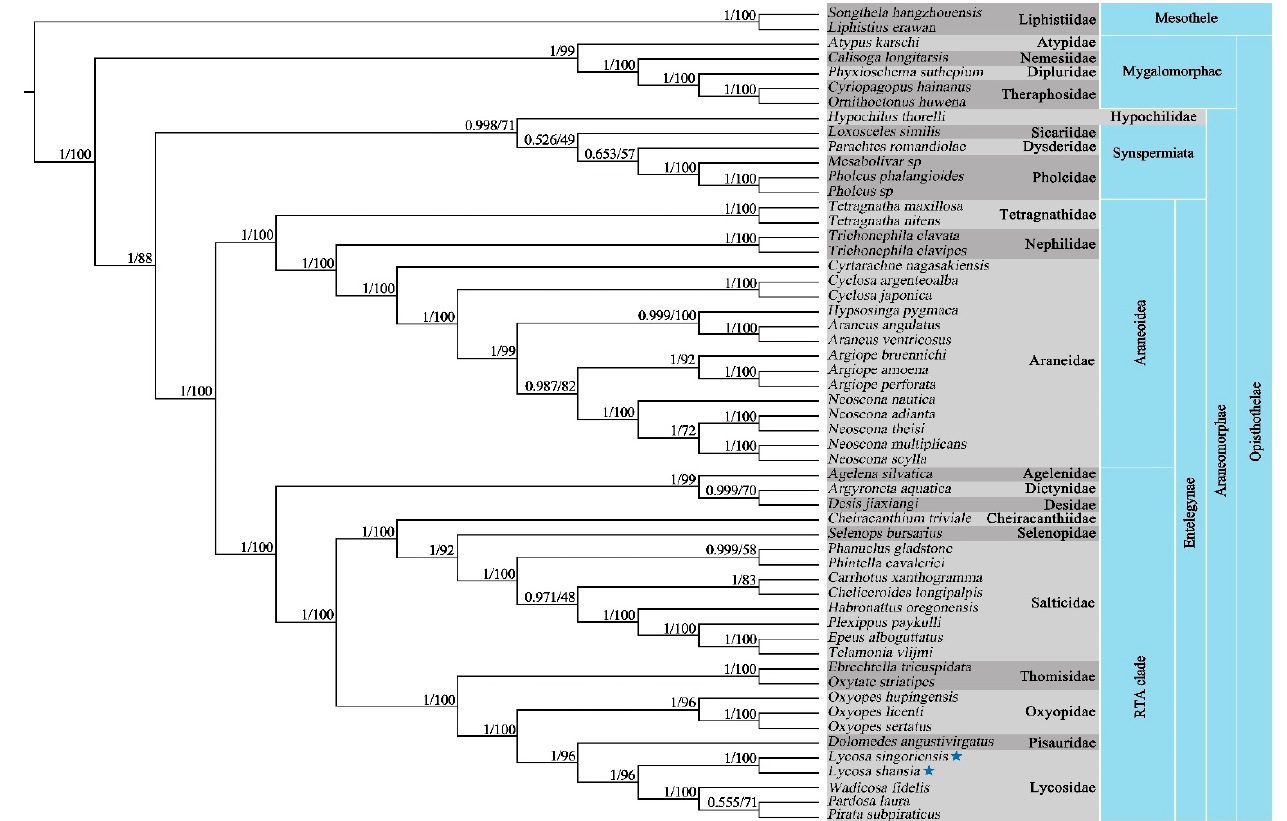
Figure 7. 13 PCGs and 2 rRNAs-based phylogenetic tree of 55 Araneae species. Numbers at nodes representing the posterior probability and bootstrap values for BI and ML analysis, respectively. Values are shown next to nodes, with posterior probability on the left and ML bootstrap support values on the right. Names with a star are the sequences obtained in this study.